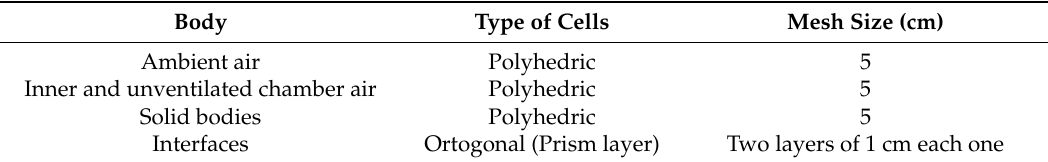
Table 5. Mesh model.